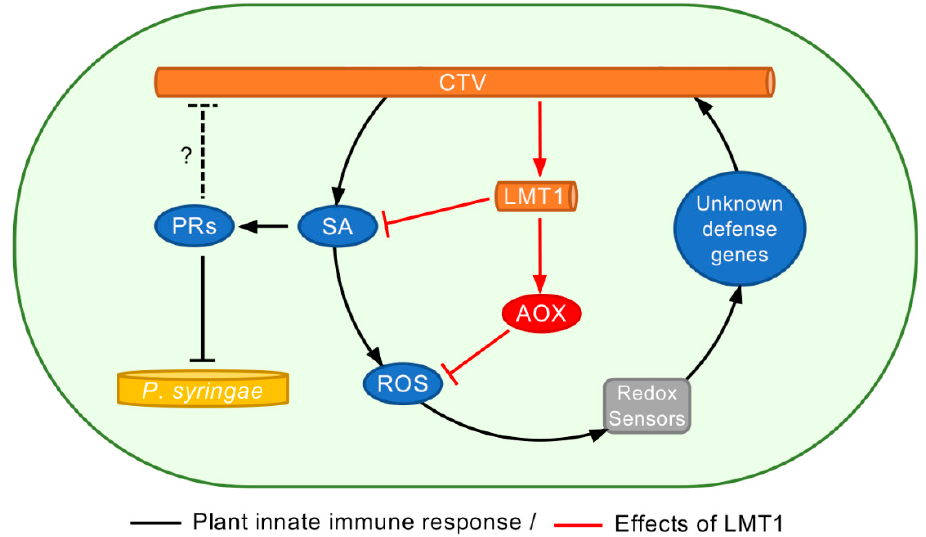
Figure 7. Schematic model of the CTV interplay with the plant innate immunity. CTV invasion triggers innate immune responses initiated by SA, which acts against virus accumulation and movement. Early production of LMT1 inhibits the accumulation of salicylic acid and also enhances the expression of an alternative oxidase, which suppresses the accumulation of reactive oxygen species. Plant innate immune responses are indicated in black lines. The effects by LMT1 are indicated in red lines. A possible effect of the PR proteins on the CTV infection is indicated as a black dotted line. PR, pathogenesis-related proteins; SA, salicylic acid; AOX, alternative oxidase; ROS, reactive oxygen species.